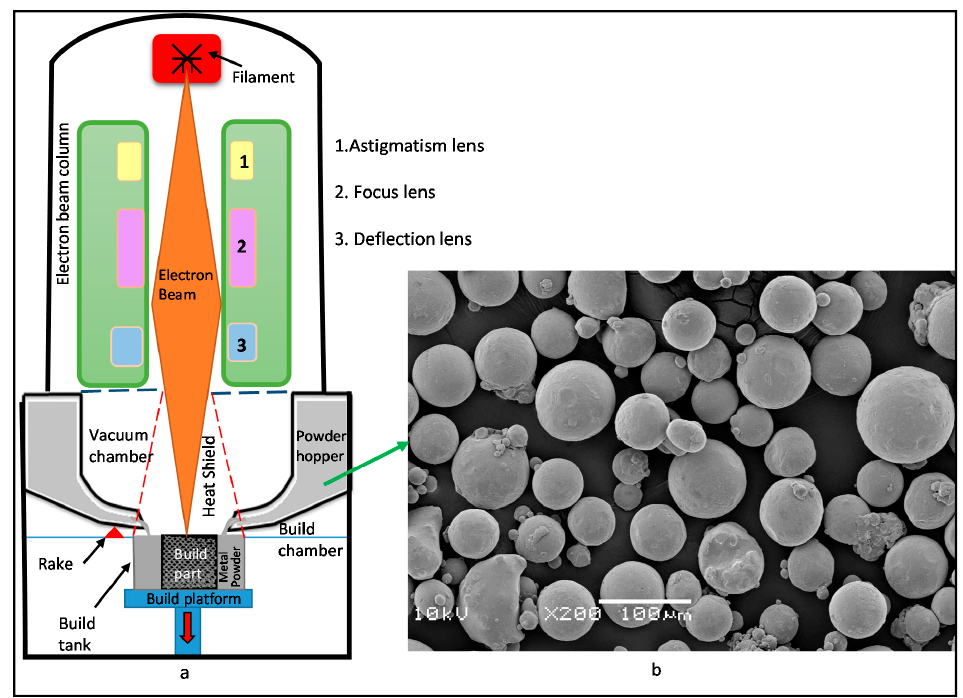
Figure 16. ( a ) Schematic diagram of the electron beam melting (EBM) A2 machine and ( b ) scanning electron microscopic image of Ti6Al4V powder.